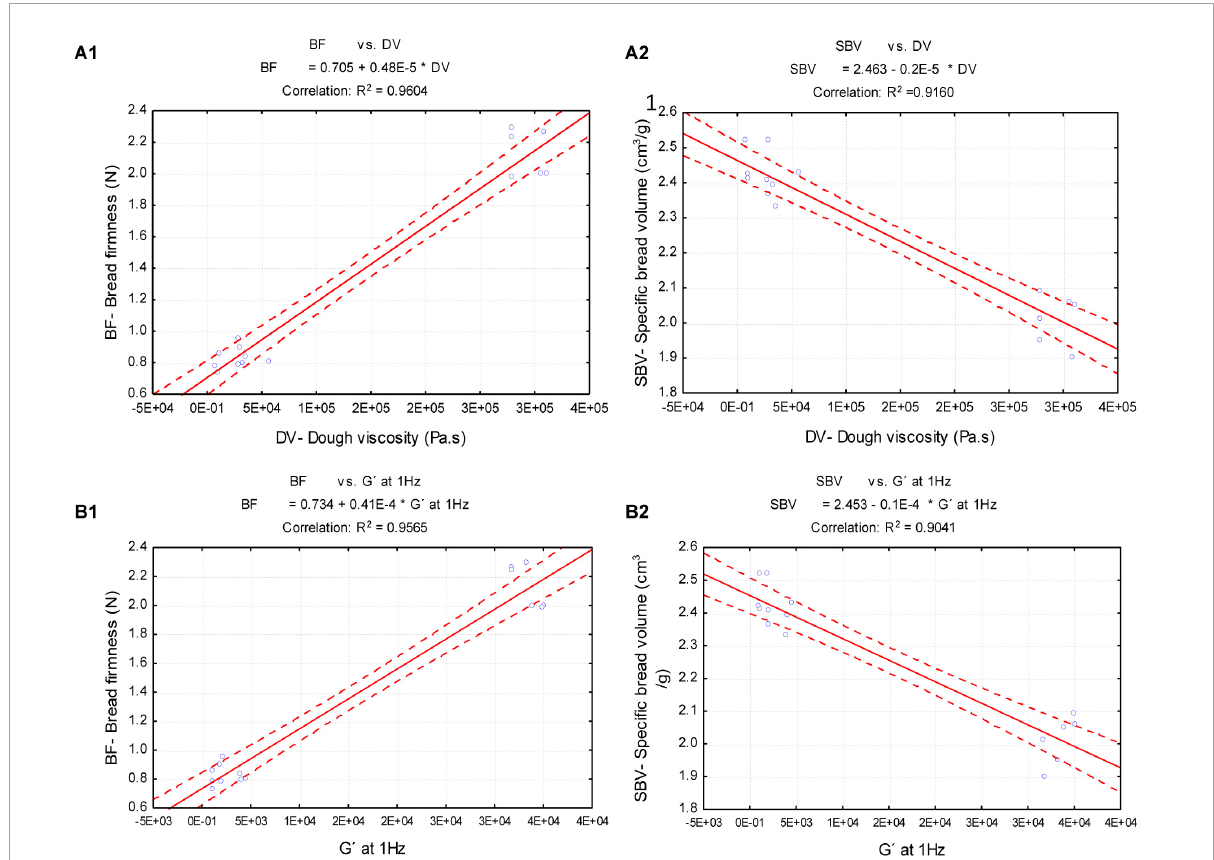
FIGURE5 Linear correlation between bread firmness (BF) and specific bread volume (SBV) with dough viscosity (DV) and elastic modulus at 1 Hz (G (cid:48) ): (A1) BF vs. DV; (A2) SBV vs. DV; (B1) BF vs. G (cid:48) (B2) SBV vs. G (cid:48) .